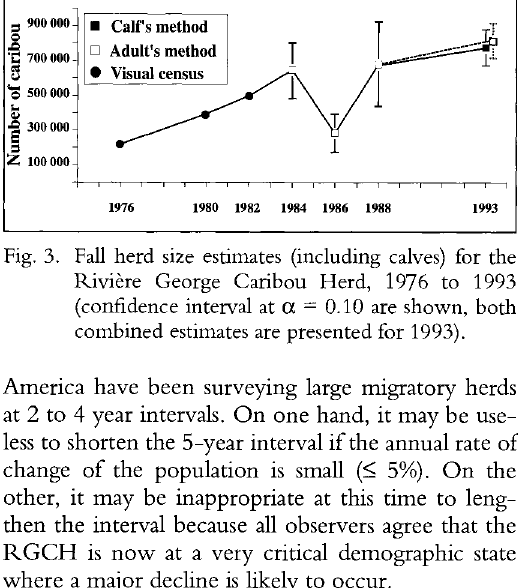
Fig. 3. Fall herd size estimates (including calves) for the Rivière George Caribou Herd, 1976 to 1993 (confidence interval at a = 0.10 are shown, both combined estimates are presented for